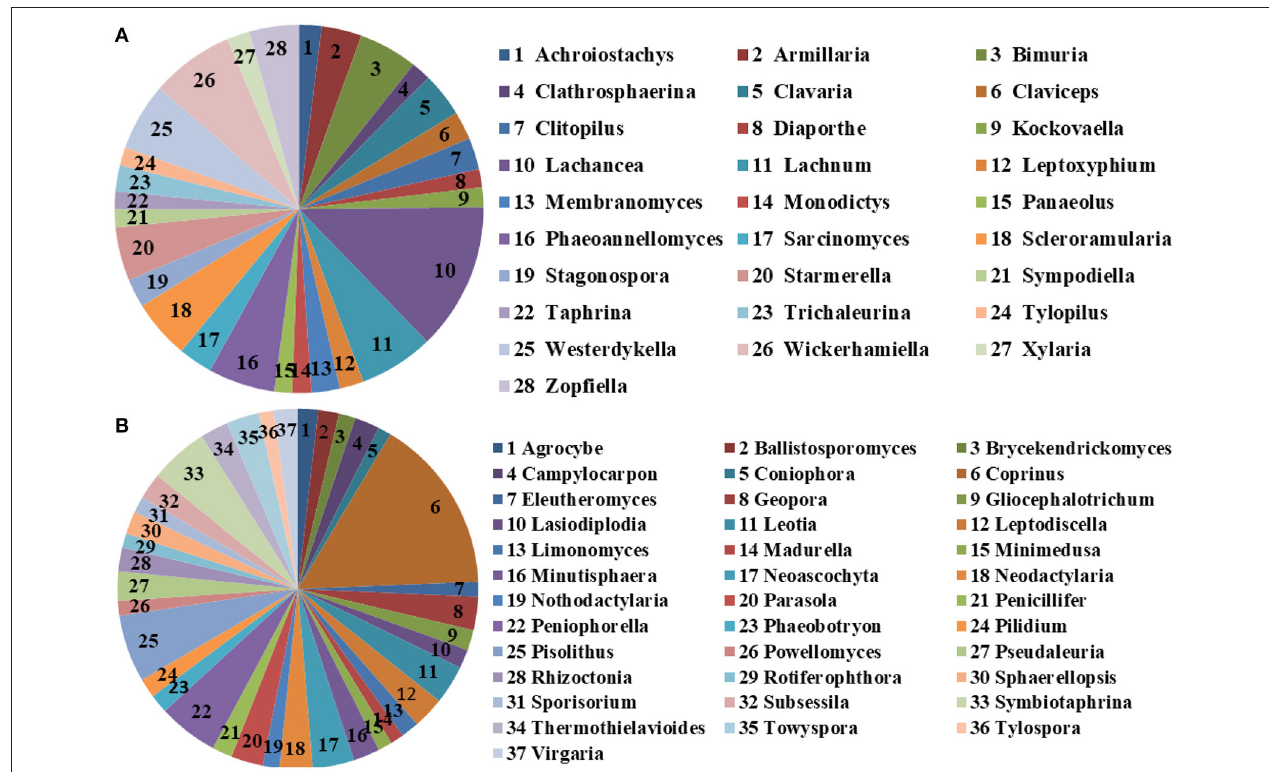
FIGURE 7 | The unique fungal genera of the two groups. (A) Genera detected only in the diarrheal group. (B) Genera detected only in the healthy group. The sector area represents the abundance of these genera.